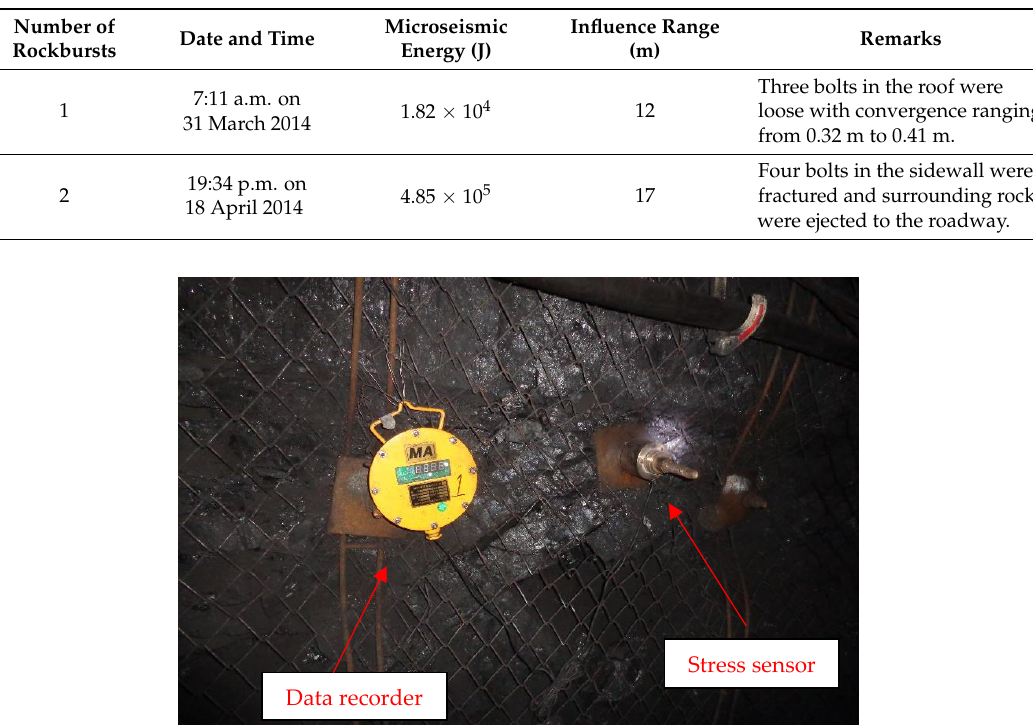
Table 4. Rockburst occurrence of track roadway in LW402103.